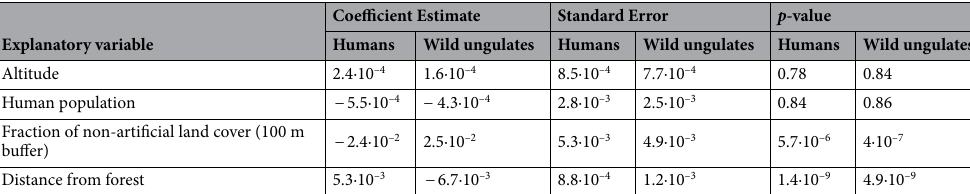
Table 3. Estimates, standard errors, and p -values of univariate coefficients of GLMs assessing the probability of identifying a blood meal from humans and wild ungulates (separate columns).